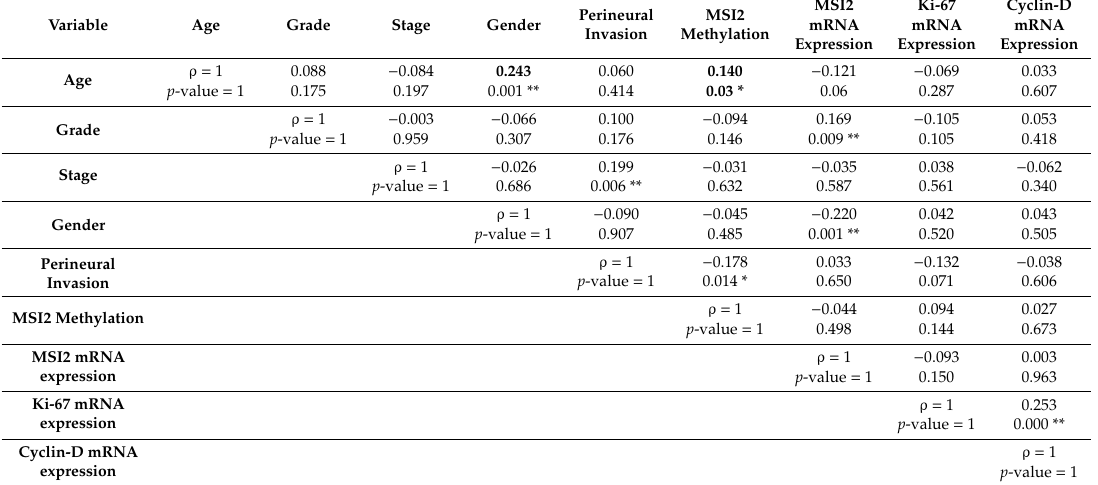
Table 2. Spearman rank correlation for the 241 Oral Squamous Cell Carcinoma (OSCC) patients included in the TCGA database. * p < 0.05; ** p <